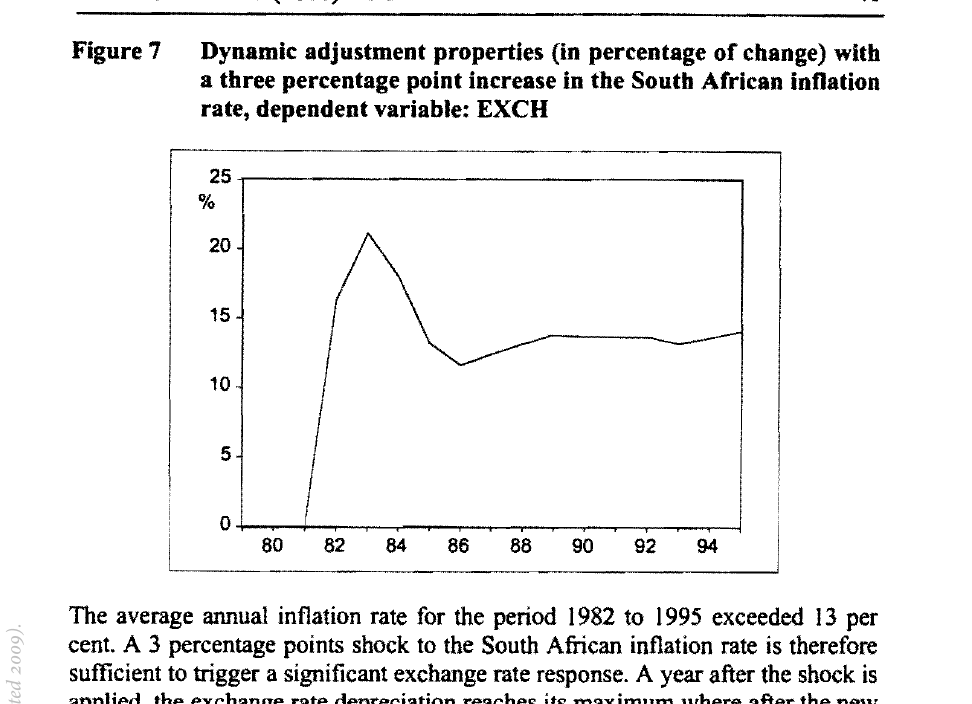
Dynamic adjustment properties (in percentage of change) with a three percentage point increase in the South African inOation rate, dependent variable: